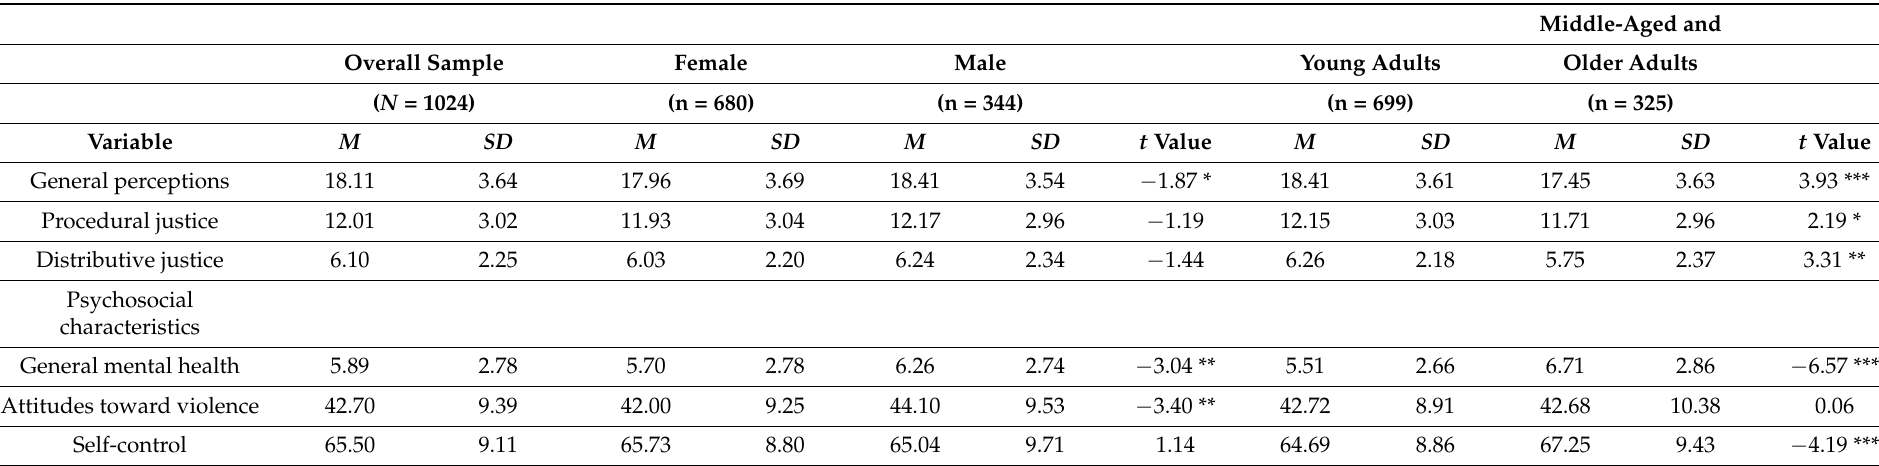
Middle-Aged and